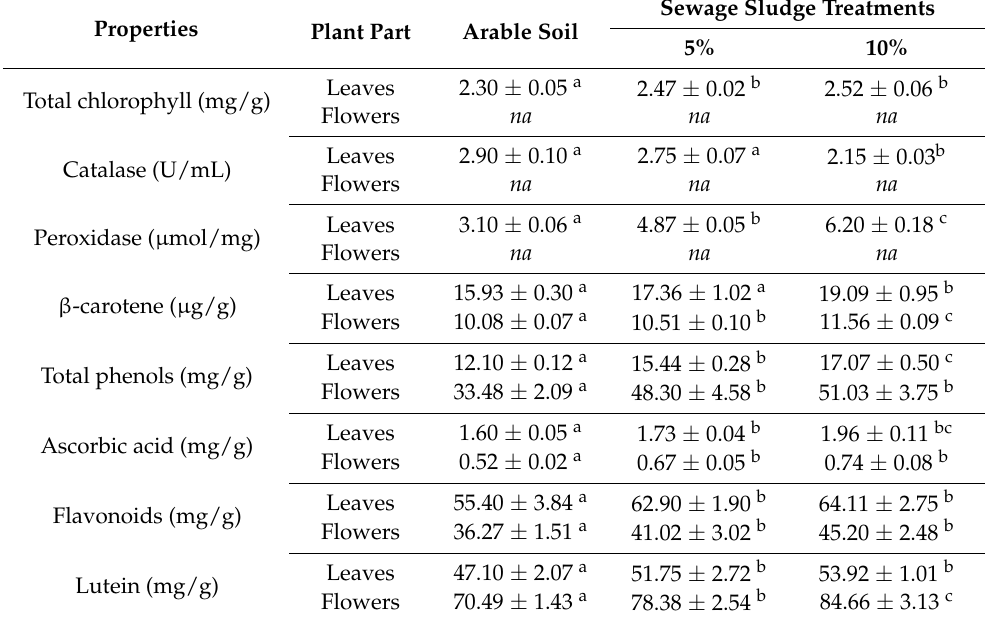
Table 3. Impact of sewage sludge amendment on biochemical characteristics of flower and leaves of cultivated